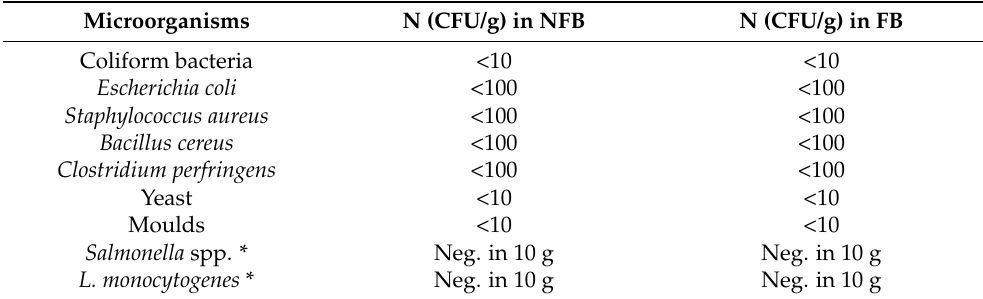
Table 1. Pathogenic bacteria, yeast, and moulds in non-fermented (NFB) and fermented A. platensis broth (FB).